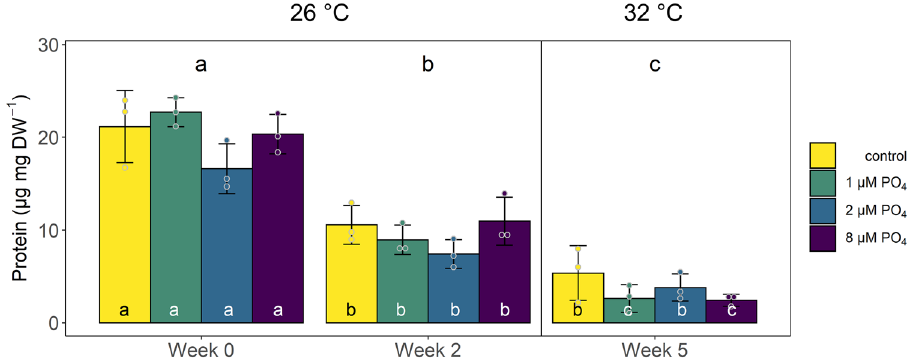
Figure 3. Protein content of Xenia umbellata colonies under experimental conditions: only temperature increase without PO 4 addition (control), 1 µM PO 4 + temperature increased from week 3 onwards (1 µM PO 4 ), 2 µM PO 4 + temperature increased (2 µM PO 4 ), and 8 µM PO 4 + temperature increased (8 µM PO 4 ). Letters above bars indicate significant differences between weeks and letters within bars indicate significant differences within the treatment over time (p < 0.05, pairwise comparison t-test, Bonferroni adjustment). Error bars represent standard deviations. Dots represent the individually measured data points. The vertical line